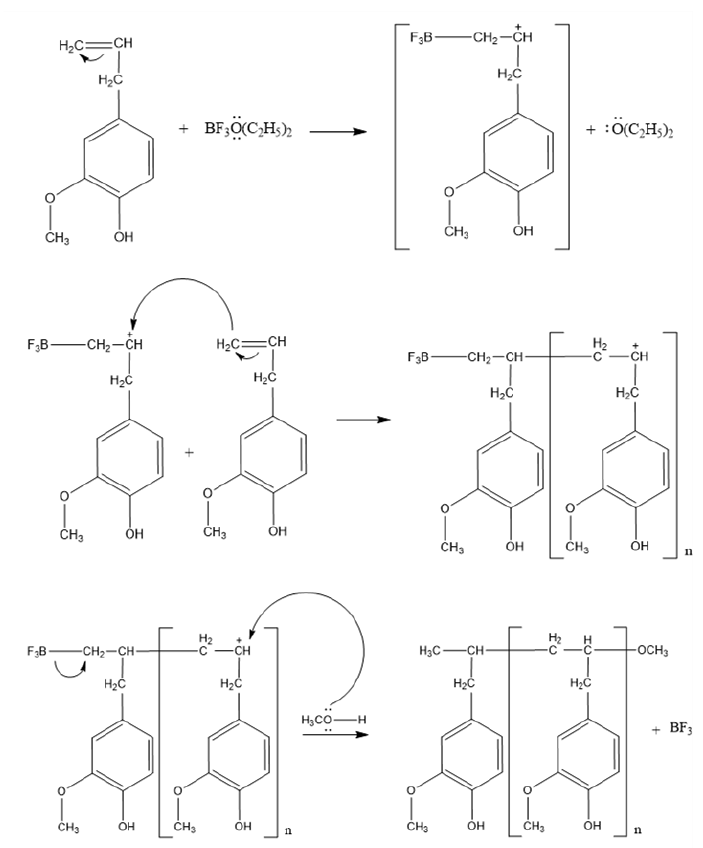
Figure 1. Polymerization process of eugenol.